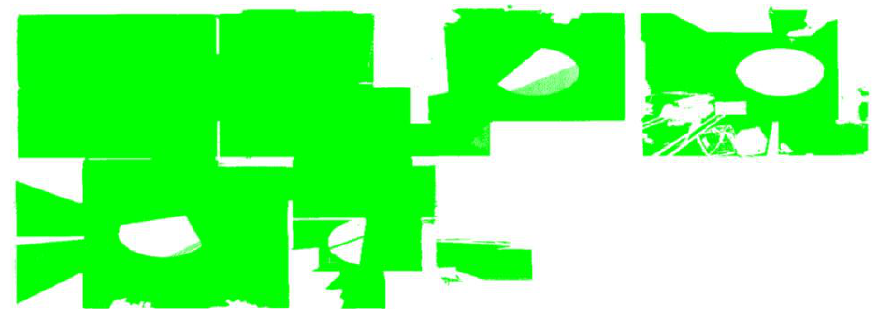
Figure 6. Gaps on planar surfaces due to missing data caused by extensive occlusions.